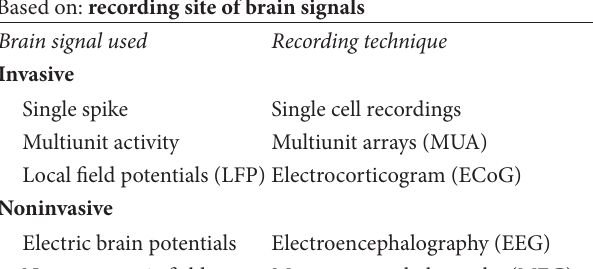
Table 1: Categories of brain-computer and brain-machine inter-